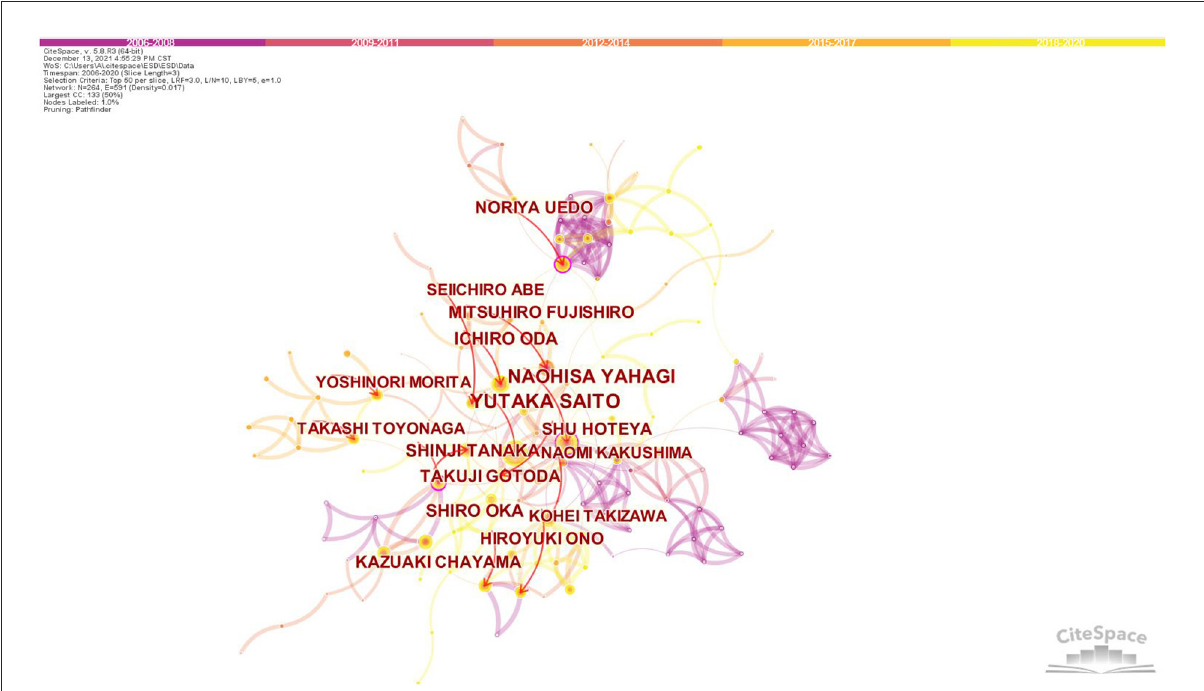
FIGURE4 Co-authorship network map in research of ESD, 2006-2020. The bigger the circle, the more original articles the author published. The shorter and thicker the connection line, the closer relationship between authors.